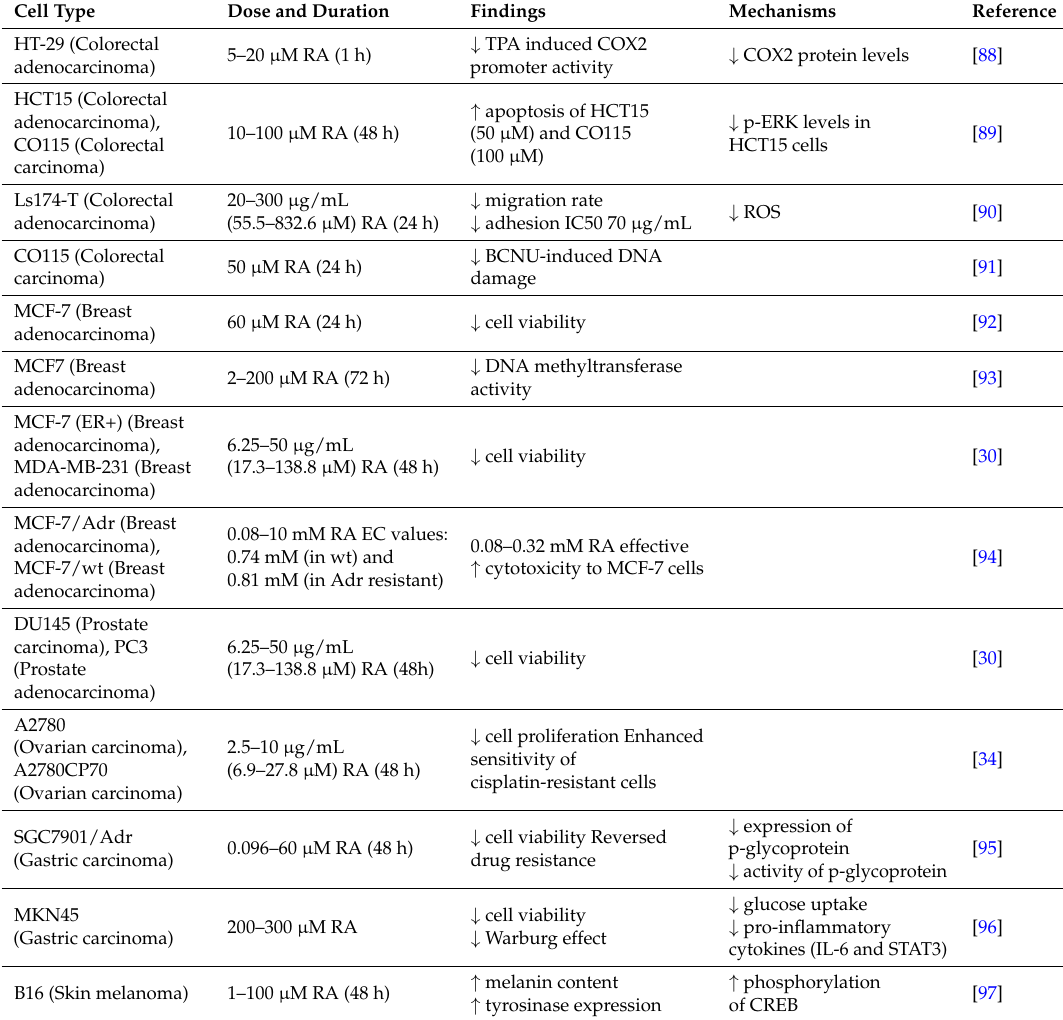
Table 13. Anticancer effects of Rosmarinic Acid (RA). In vitro studies: colon, breast, prostate, ovarian, gastric and skin